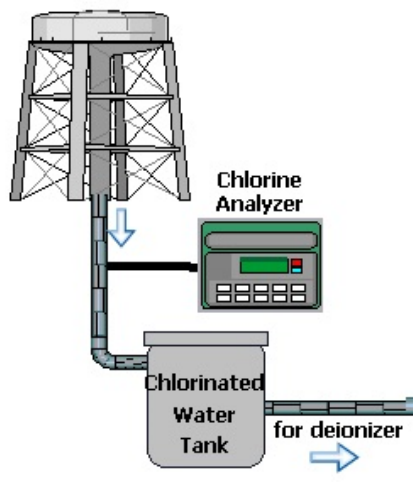
Figure 1. Pre-treatment